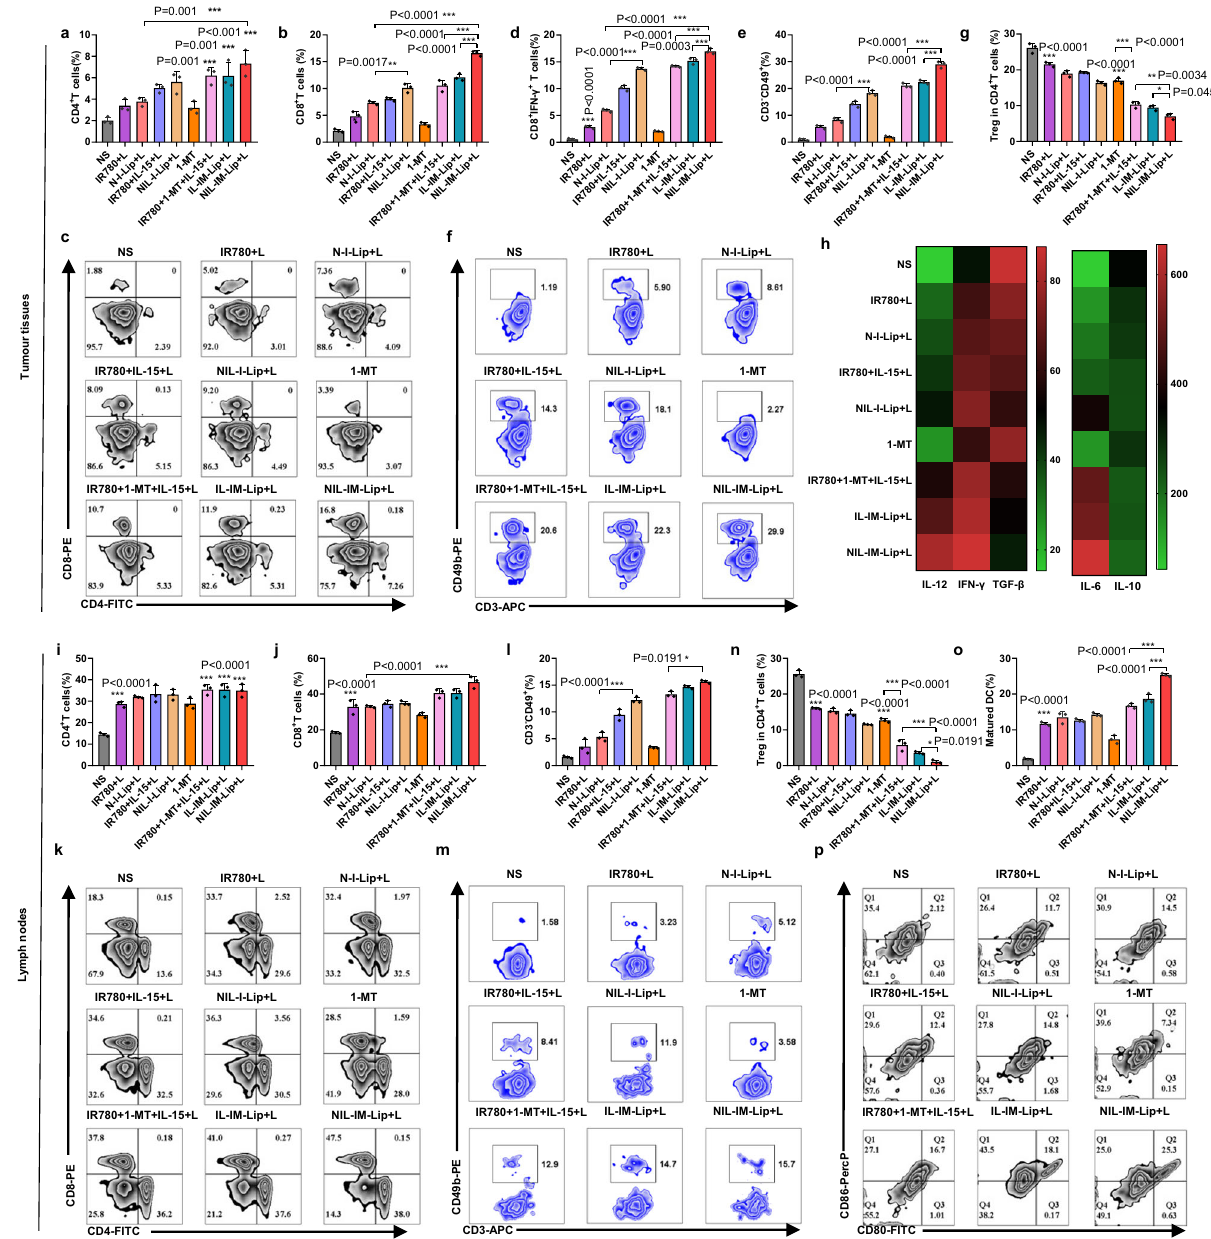
Fig. 7 | Effects ofNIL-IM-Lip+L treatment on the simultaneous coactivation of CTLsandNKcellsandthereversionofthesuppressiveconditionsintheTLIME in the B16F10 model. a – c Flow cytometric analysis of intratumoural CD4 + T cells andCD8 + Tcells. d Flowcytometricanalysisofthein fi ltrationofCTLsintotumours ( n = 3 biologically independent experiments per group). e , f Flow cytometric analysis of NK cell in fi ltration into the tumours ( n = 3 biologically independent experiments per group). g Flow cytometric analysis of the in fi ltration of Treg cells gated on CD4 + lymphocytes in the tumours ( n = 3 biologically independent experiments per group). h Quantitative ELISA analysis of the cytokines in the tumour tissues from mice treated with different formulations ( n = 3 biologically independent experiments per group). i – k Flow cytometric analysis of the